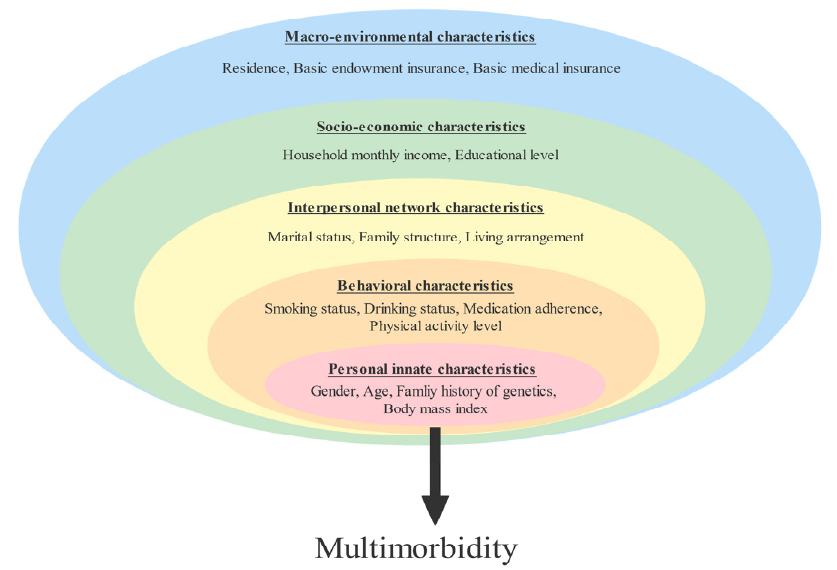
Figure 1. Health ecological model of multimorbidity.